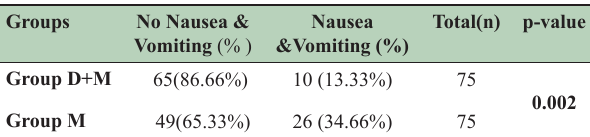
Table-II: Association among nausea, vomiting, and groups.